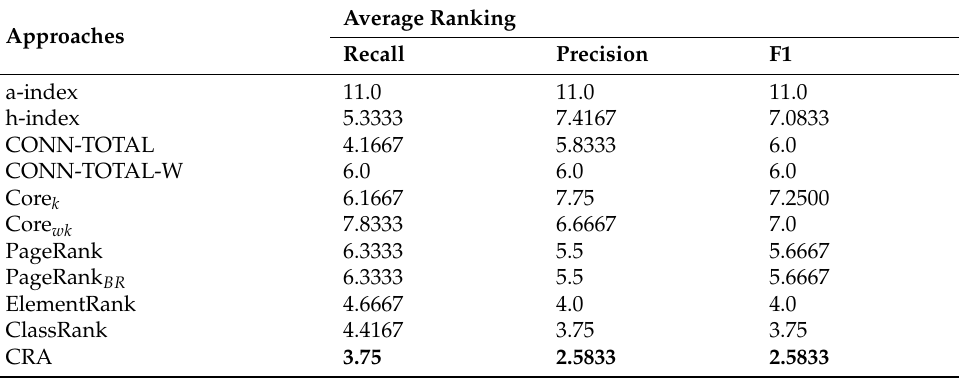
Table 7. Average ranking of the CRA and other baseline